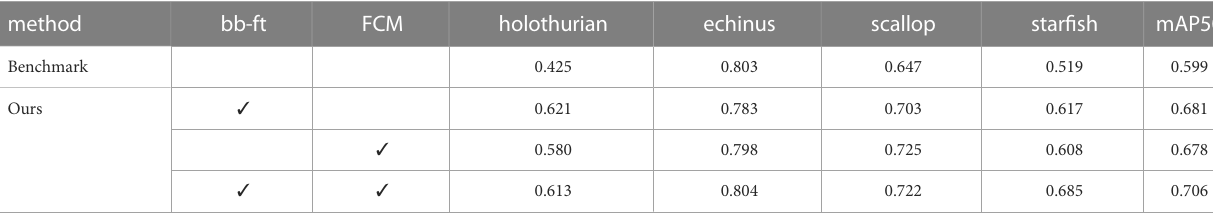
TABLE 3 Our ablation experiments on the S-UODAC dataset.